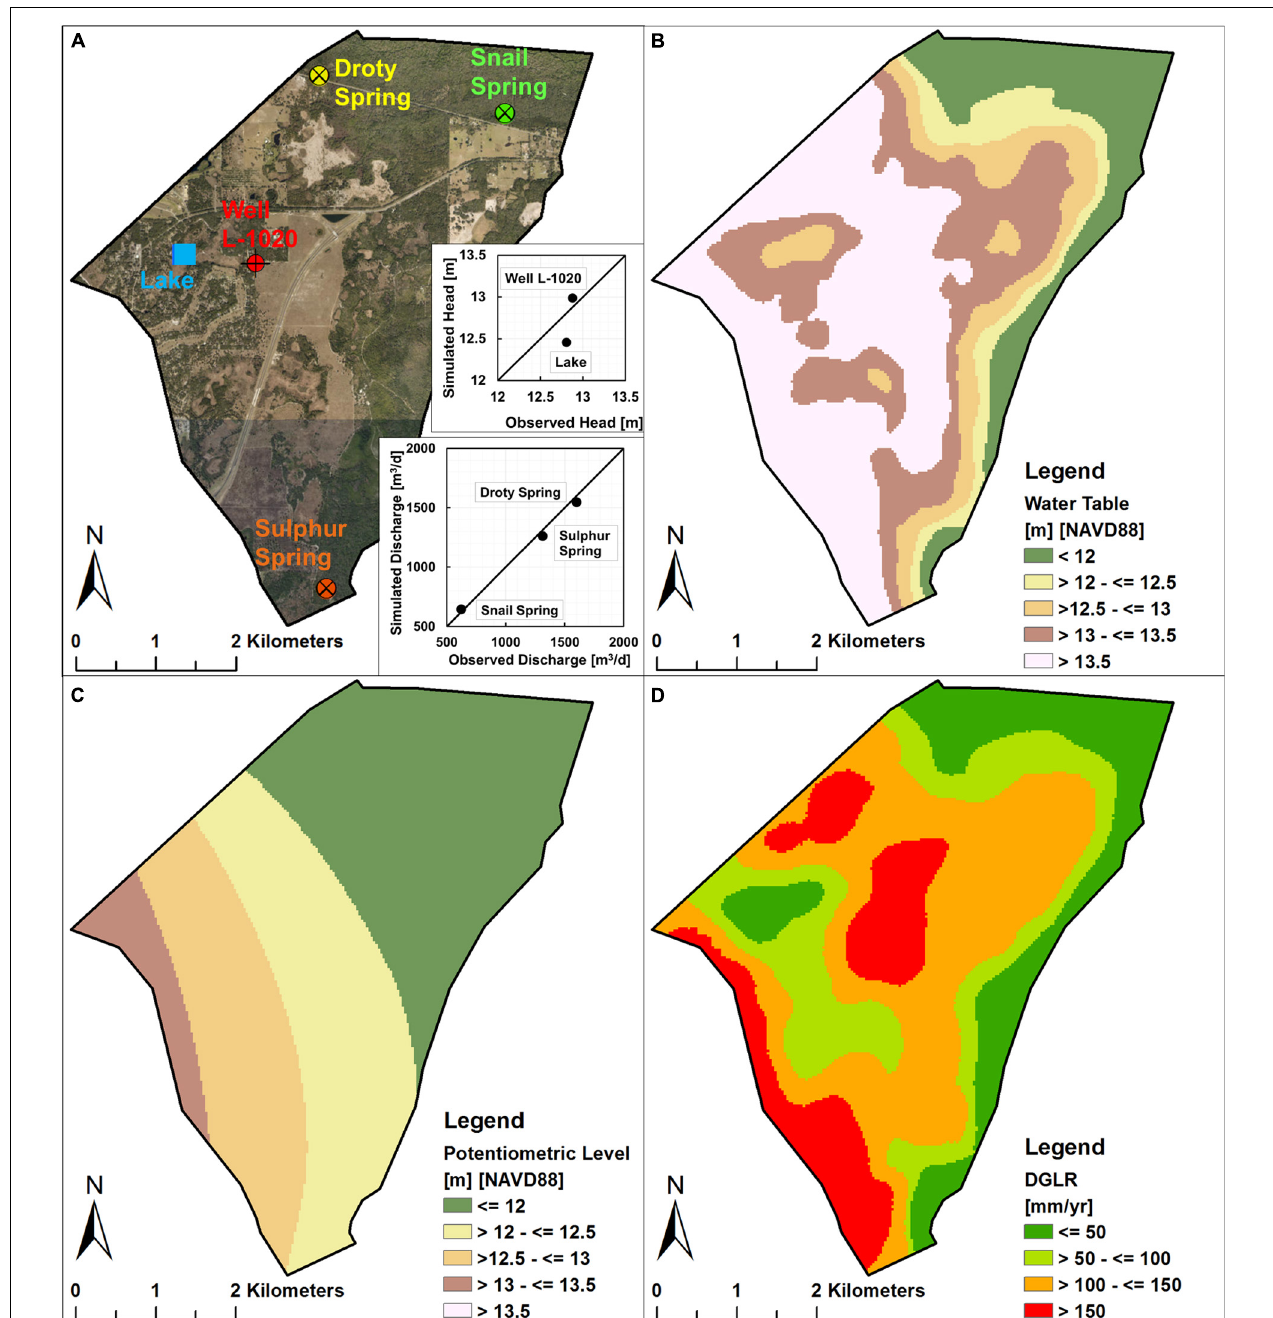
FIGURE 3 | (A) Locations of field-measurements (modified from the GIS database maintained by St. Johns River Water Management District) and scatter diagram showing the goodness of fit between the observed and simulated heads and spring discharges; (B) spatial variation of simulated water tables; (C) spatial variation of simulated potentiometric levels; (D) spatial variation of simulated